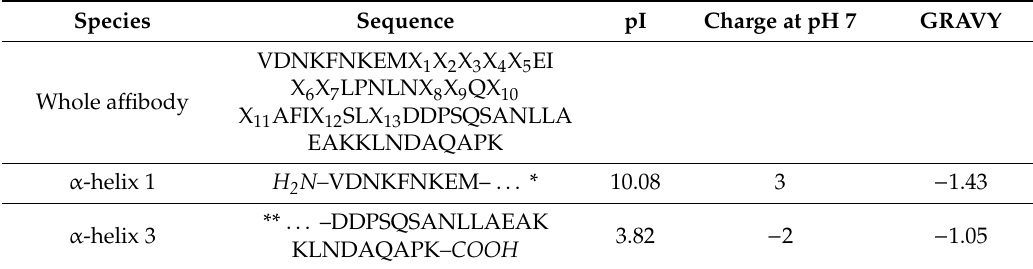
Table A1. Amino acid sequence of a ffi bodies, where X 1 –X 13 indicate the randomized positions, as well as the isoelectric point, net charge at pH 7, and grand average hydroxypathy index (GRAVY) index of the constant regions. Note: to mimic its connection to the rest of the a ffi body molecule, the C-terminus of sequence * was amidated and the N-terminus of sequence ** was